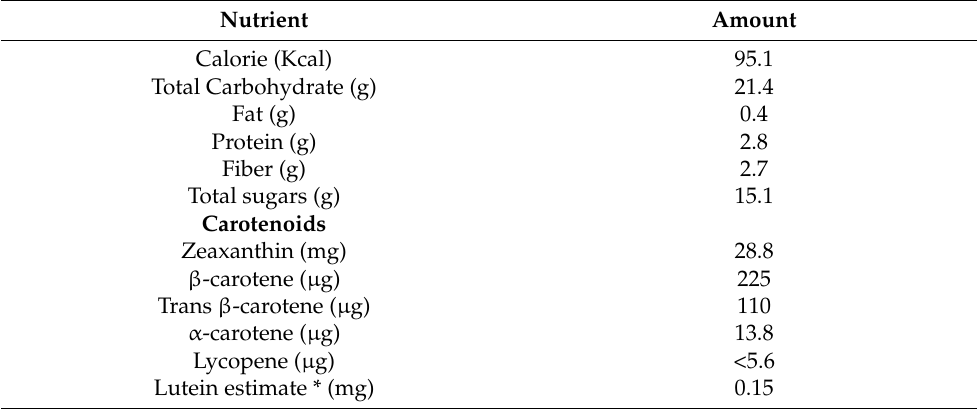
Table 2. Composition of select nutrients and carotenoids in 28 g of goji berries. * Lutein estimated from goji berries cultivated in Ningxia province, China (Zhao et al., 2013).